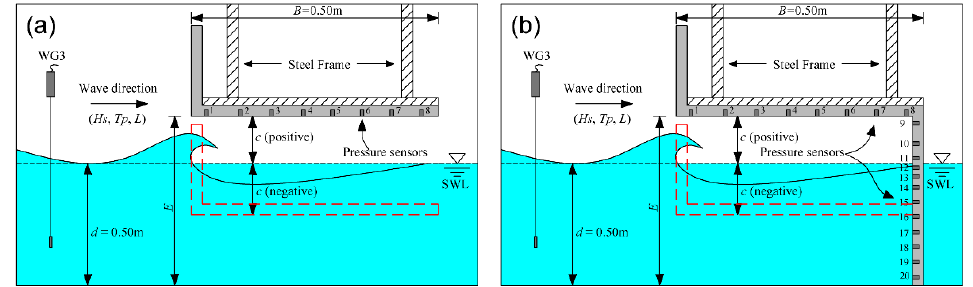
Figure 2. Two configurations of tested physical models; ( a ) the simple horizontal slab; ( b ) the vertical wall with overhanging horizontal cantilever slab.